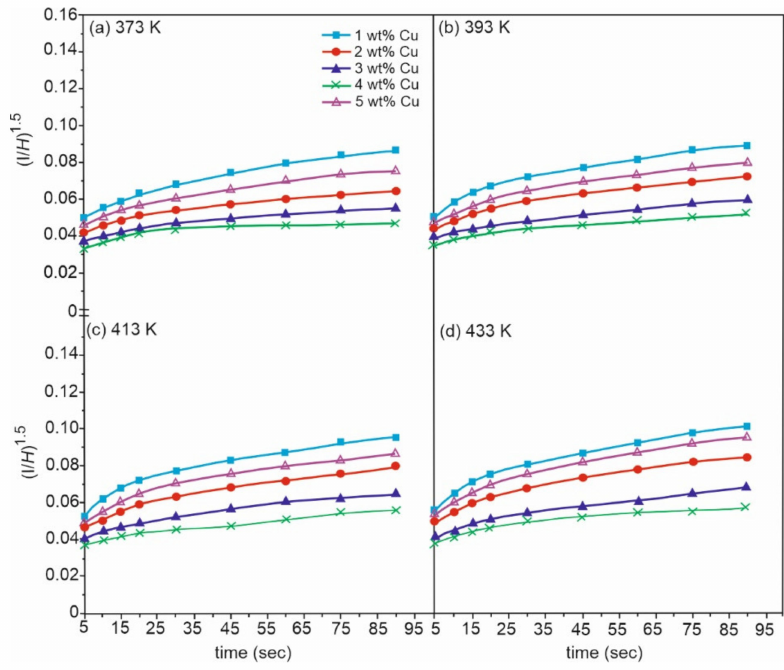
Figure 22. Variation of creep rate at increasing annealing temperature [59].